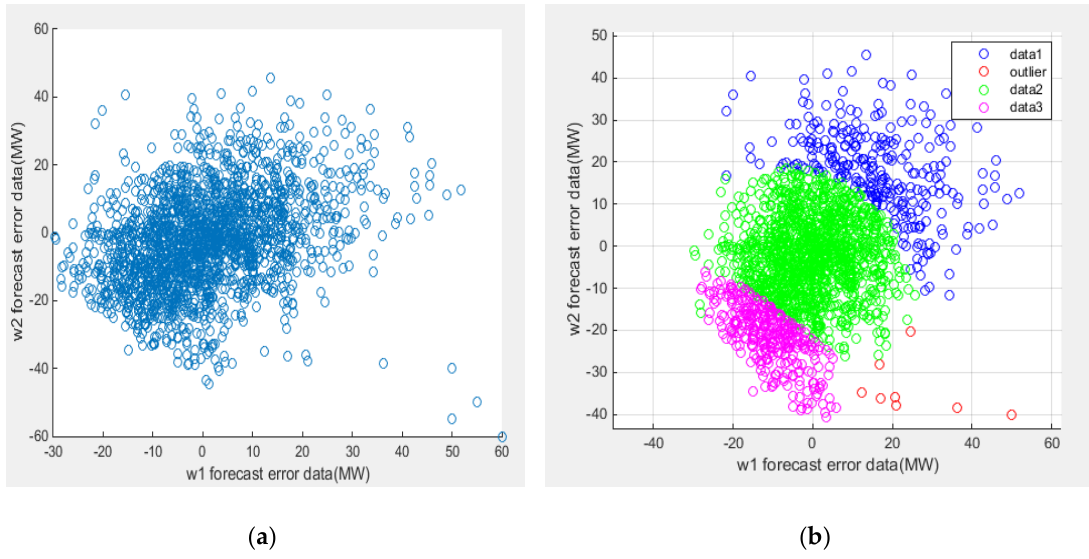
Figure 3. ( a ) Scatter plot of data set; ( b ) Gaussian mixture model (GMM) data cluster.